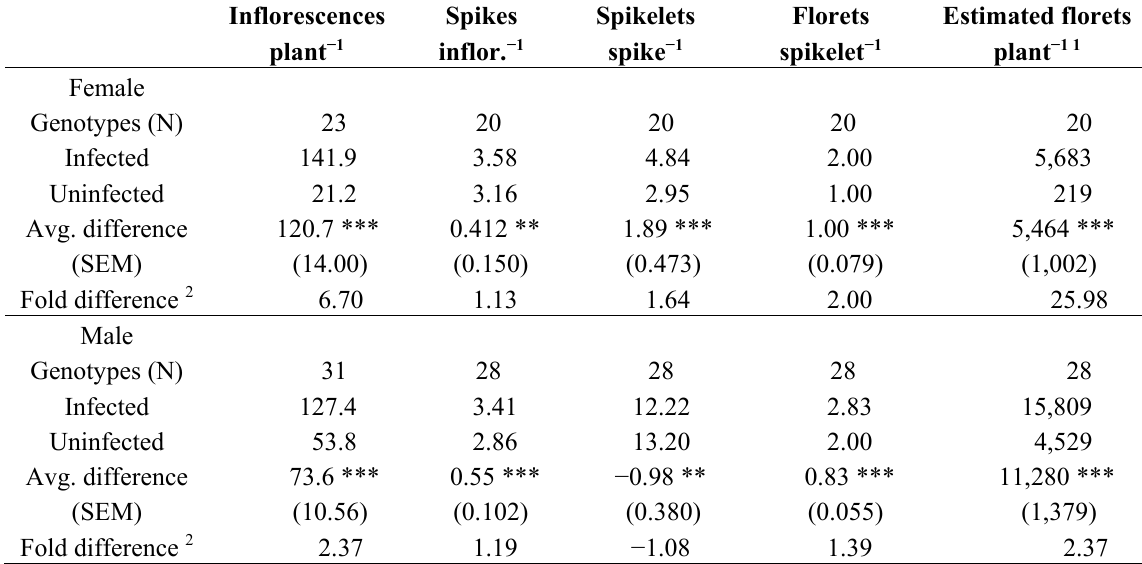
Table 2. Measured and estimated means of seed yield components for female and male genotypes of buffalograss that were either infected or uninfected with the pistil smut fungus. For each genotype, two replicate clonal plants were infected with pistil smut and two remained uninfected. Means are the clonal averages across genotypes from greenhouse grown plants. Mean differences between infected and uninfected clones were tested for significance using Student’s paired t-test. Standard error of mean = (SEM). Inflorescences Spikes Spikelets Florets Estimated florets plant − 1 inflor. − 1 spike − 1 spikelet − 1 plant − 1 1 Female Genotypes (N) 23 20 20 20 20 Infected 141.9 3.58 4.84 2.00 5,683 Uninfected 21.2 3.16 2.95 1.00 219 Avg. difference 120.7 *** 0.412 ** 1.89 *** 1.00 *** 5,464 *** (SEM) (14.00) (0.150) (0.473) (0.079) (1,002) Fold difference 2 6.70 1.13 1.64 2.00 25.98 Male Genotypes (N) 31 28 28 28 28 Infected 127.4 3.41 12.22 2.83 15,809 Uninfected 53.8 2.86 13.20 2.00 4,529 Avg. difference 73.6 *** 0.55 *** − 0.98 ** 0.83 *** 11,280 *** (SEM) (10.56) (0.102) (0.380) (0.055) (1,379) Fold difference 2 2.37 1.19 − 1.08 1.39